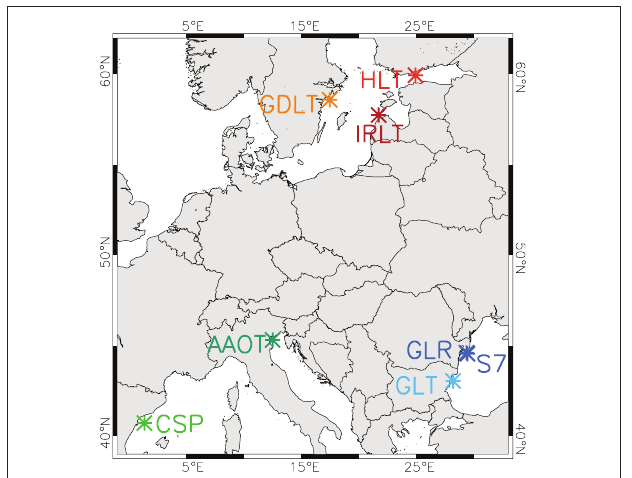
FIGURE 1 | Maps of the AERONET-OC sites used in the analysis (see text for the definition of their